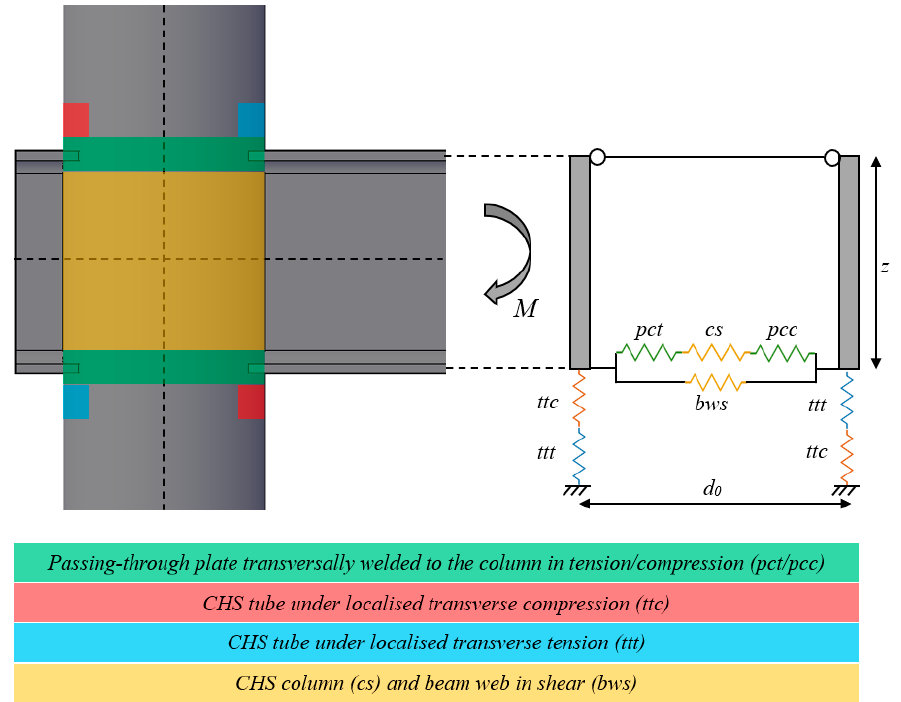
Figure 2. Selection of the nodal components according to the component method approach.